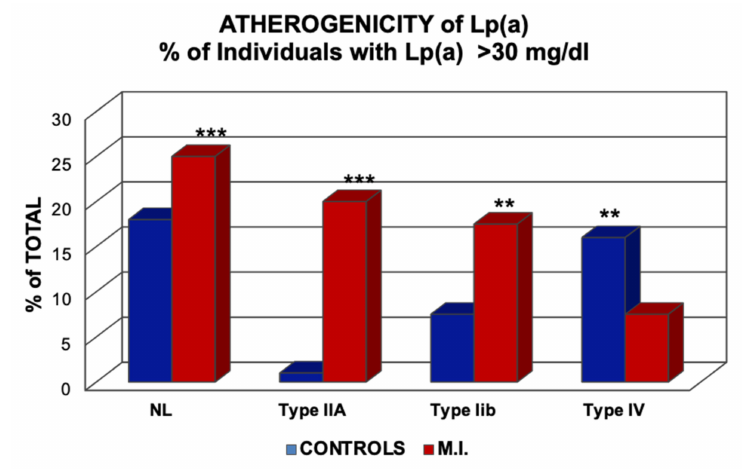
Figure 11. Risk of myocardial infarction (MI) concerning elevated Lp(a). The columns indicate the percentage of individuals with >30 mg/dL Lp(a) in normo-lipemics and patients with hyperlipopro- teinemia Types-IIa, IIb, and -IV, according to the Fredrickson classification. ** p > 0.01; *** p < 0.001. Values shown in the Figure are from Ref.